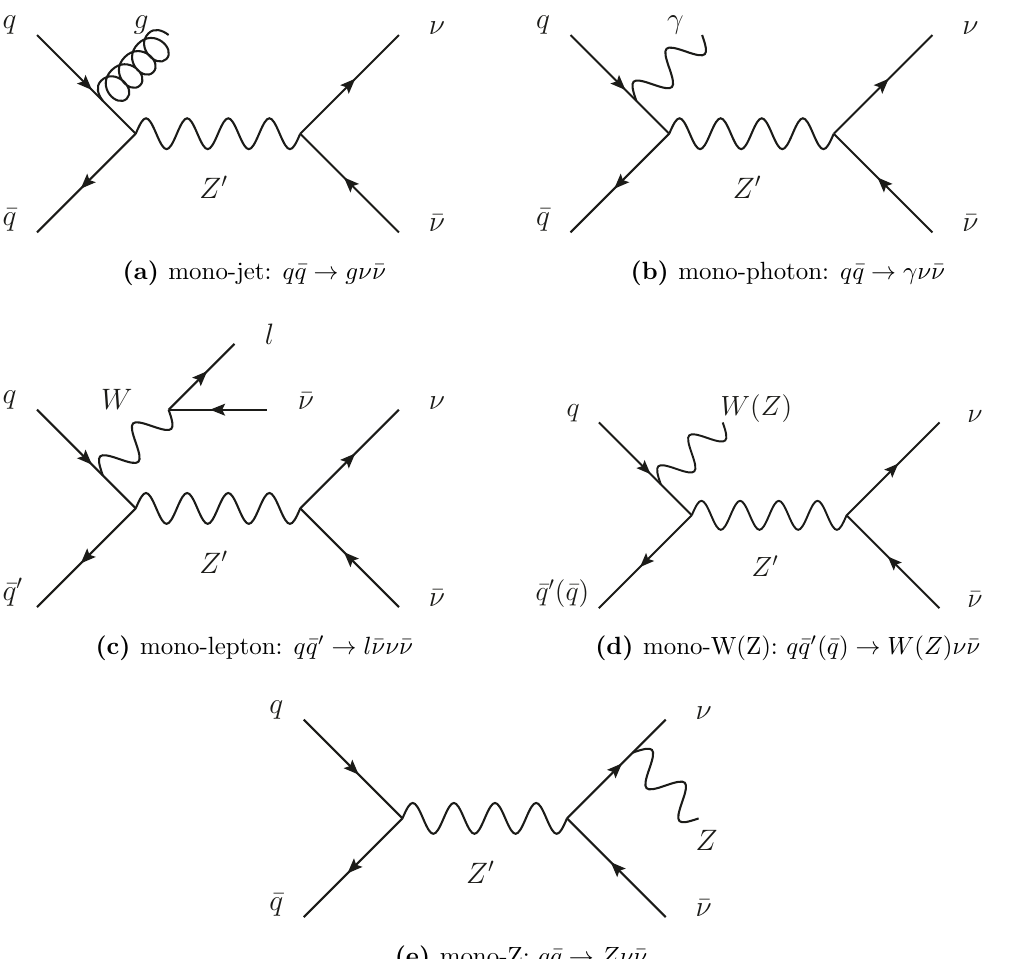
Figure 1. Representative Feynman diagrams at leading order for the process q ¯ q → gν ¯ ν , q ¯ q → γν ¯ ν , q ¯ q 0 → l ¯ νν ¯ ν , q ¯ q 0 (¯ q ) → W ( Z ) ν ¯ ν and q ¯ q → Zν ¯ ν . Flavor indices of neutrinos are suppressed for